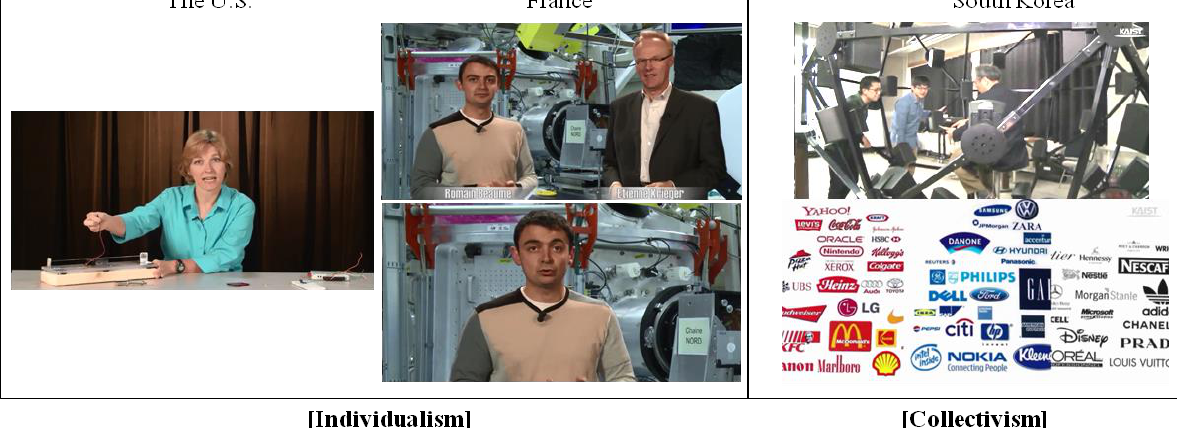
Figure 2. Examples of individualism and